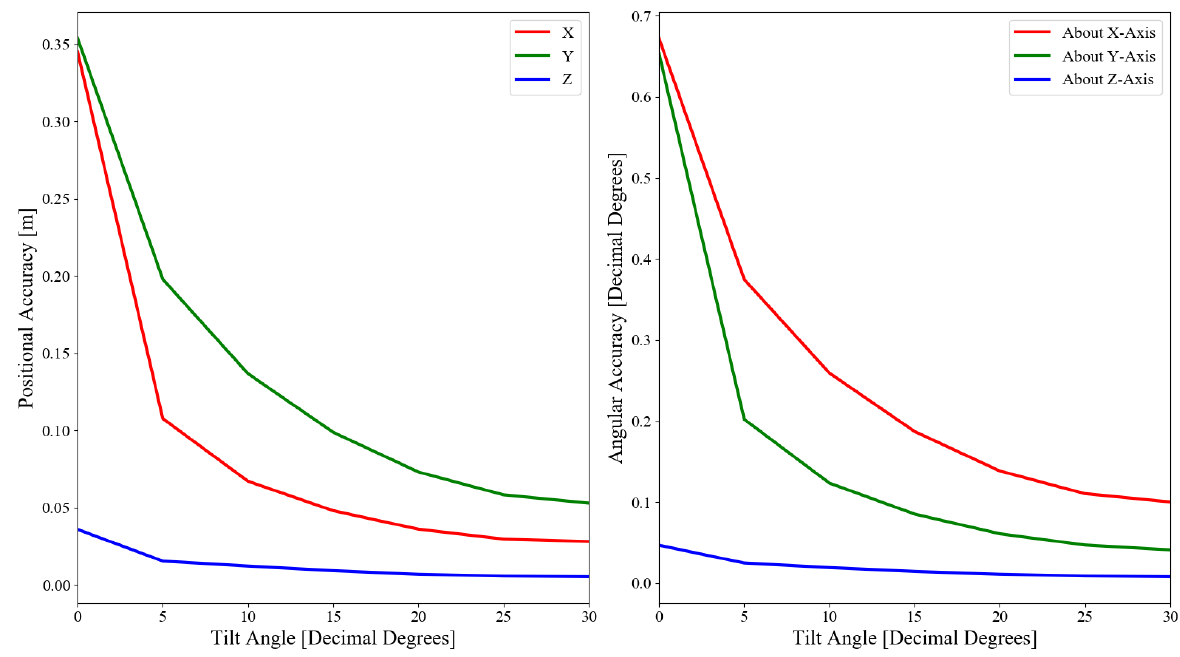
Figure 6: Effect of angle between the sensors’ optical axes on pose accuracy